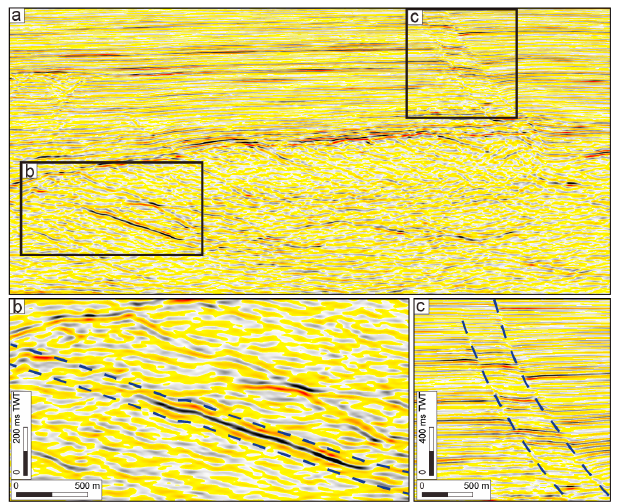
Figure 4. Methods of interpreting intra-basement and rift-related structures. (a) Cross section showing the observed fault structures in the stratigraphic cover and basement rocks. (b) A close-up showing the observed thin intra-basement reflection packets. (c) A close-up showing the interpretation method of the rift-related fault